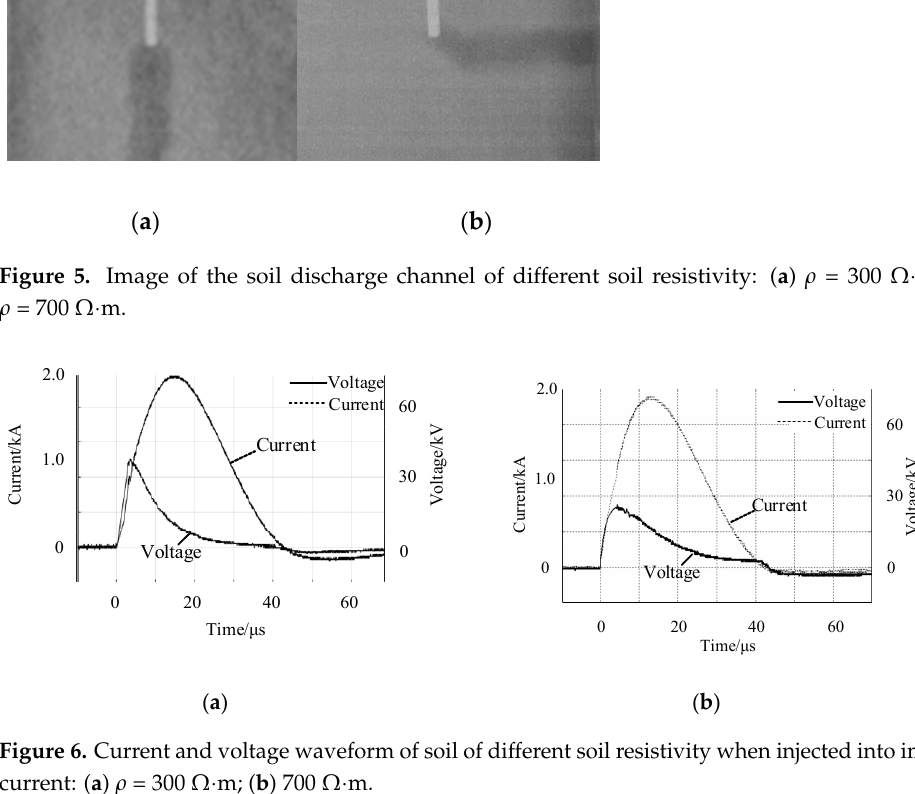
Figure 7. V I and reciprocal of R ch of different soil resistivity. As can be seen from Figure 7, The change rule of the equivalent value of the soil discharge volume per unit electric current is the same as that of the reciprocal of the grounding resistance of the grounding electrode. The calculated correlation coefficient r is shown in Table 2. Table 2. V I and reciprocal of R ch of different soil resistivity. The Variables 0.002 5 According to Table 2, under different soil resistivity, the correlation coefficient r of V I and R ch ’s reciprocal is above 0.9, showing a significant correlation. Therefore, the evalua- tion method of the near-area soil impulse dispersion performance proposed in this paper can directly depict the impulse dispersion performance of soil media, it is proved to be feasible and effective enough to enrich the evaluation system of the impulse dispersion ability of a grounding device, complementing the evaluation method of the soil impulse dispersion performance.